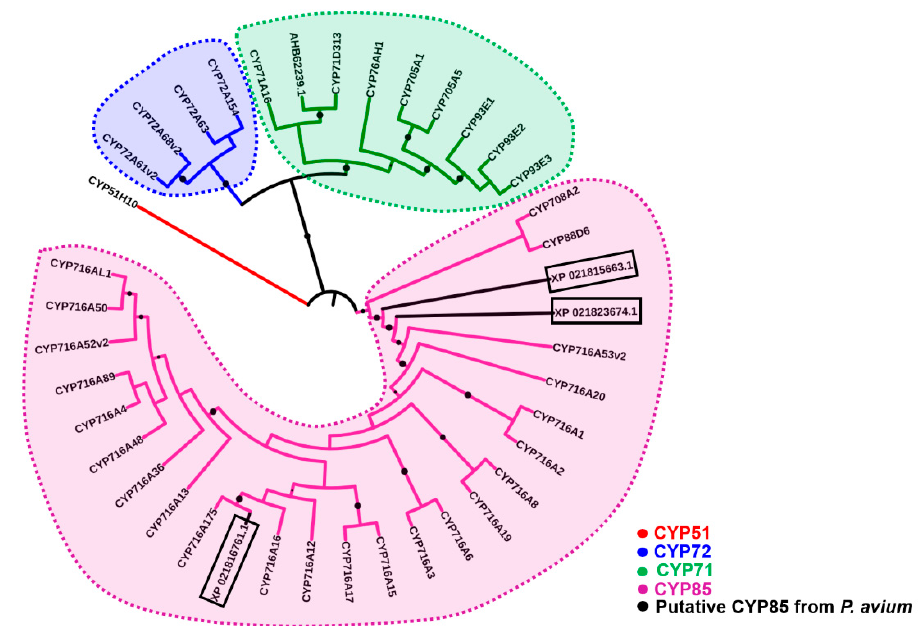
Figure 2. Maximum likelihood phylogenetic tree (number of bootstrap alignments in ultrafast mode: 1000) of different CYP protein sequences (conserved regions only) from the plant species used by Andre and colleagues [11] and from sweet cherry (boxed). The FASTA protein sequences used to build the tree are provided in Supplementary Information. Bootstrap values ranging from 0.8 to 1 are displayed as black circles; the bigger the circle, the higher the bootstrap value.